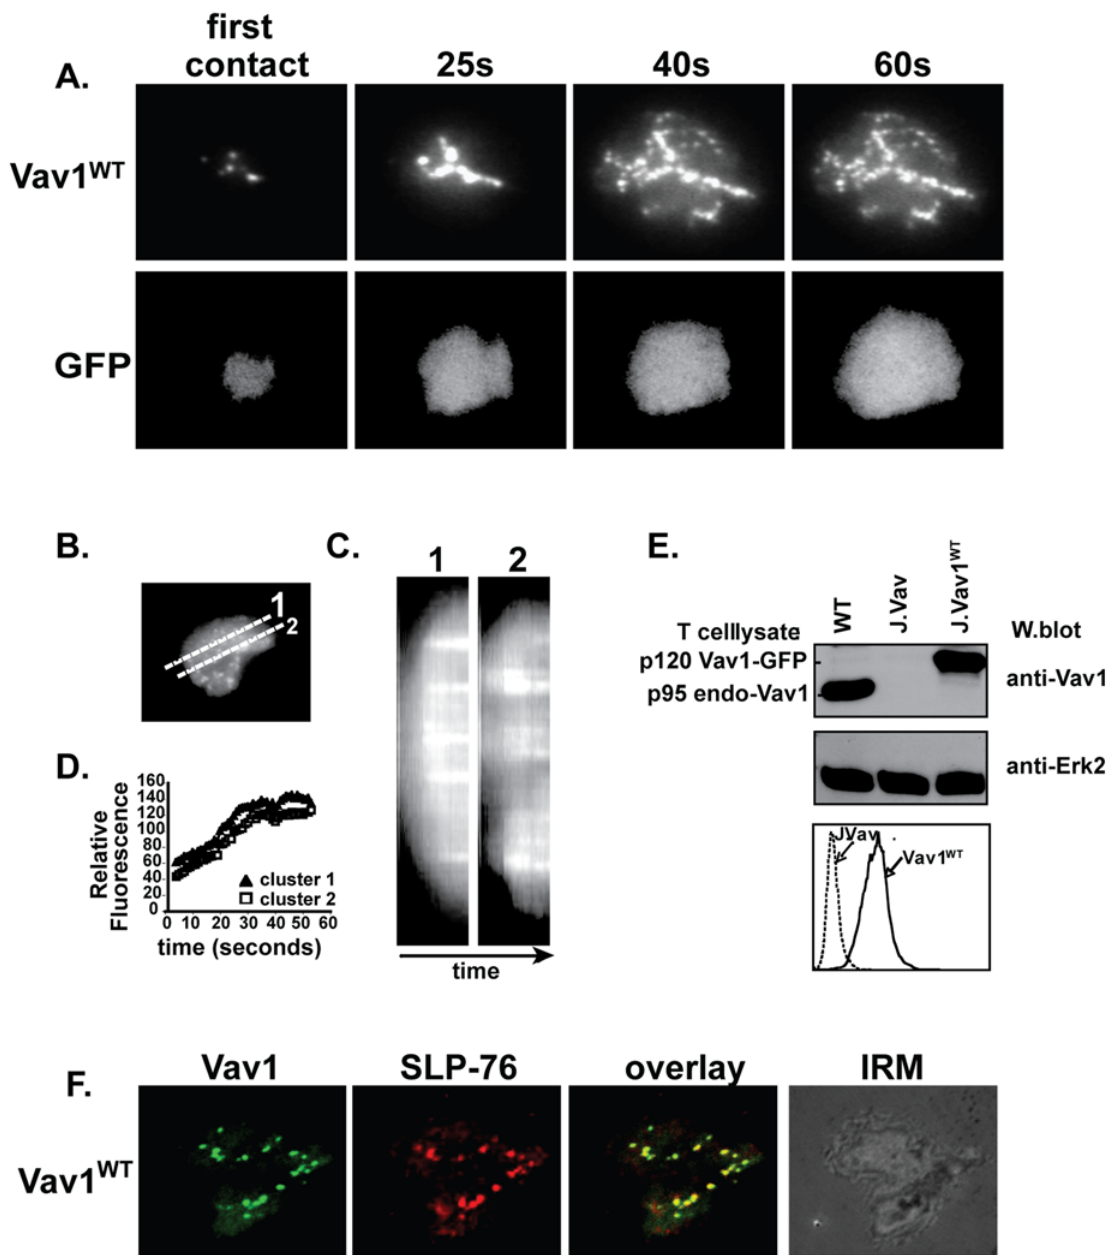
Figure 2. Vav1 forms microclusters in response to TCR stimulation. (A) J.Vav1 WT cells were activated on anti-CD3-coated coverslips. Images were obtained in real time using TIRFM (times, above images). (B) Diagonal lines indicate sections of a representative J.Vav1 WT cell taken for kymographic analysis. (C) Fluorescence of individual Vav1-GFP microclusters over time (60s) are presented as horizontal ‘‘streaks’’ in kymographs for sections shown in (B). (D) Mean fluorescence intensity over time (60s) of individual Vav1-GFP clusters in stimulated J.Vav1 WT cells. Shown are representative images of n=5. (E) Vav1 WT -GFP expression. Shown are immunoblots with anti-Vav1 antibodies and FACS of J.Vav1 WT cells. (F) Vav1- GFP and SLP-76 microcluster formation in J.Vav1 WT cells, activated on anti-CD3-coated coverslips for 2